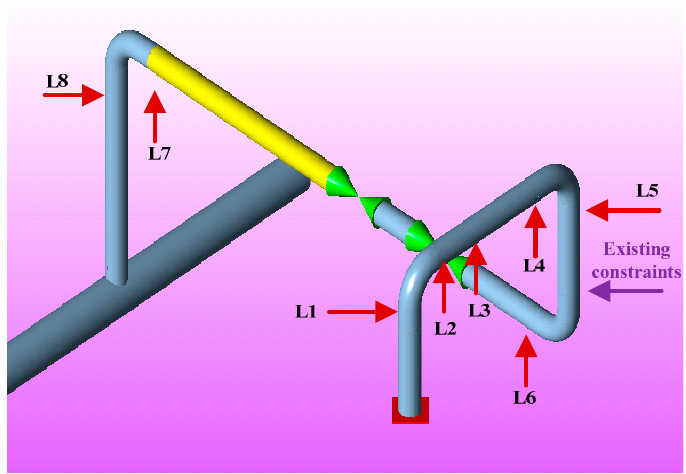
Figure 25. Eight locations of constraints added to the pump outlet pipe. Table 13. First order natural frequency of the pump outlet pipe after the constraint is added. Location of the Constraint First Order Natural Frequency (Hz)